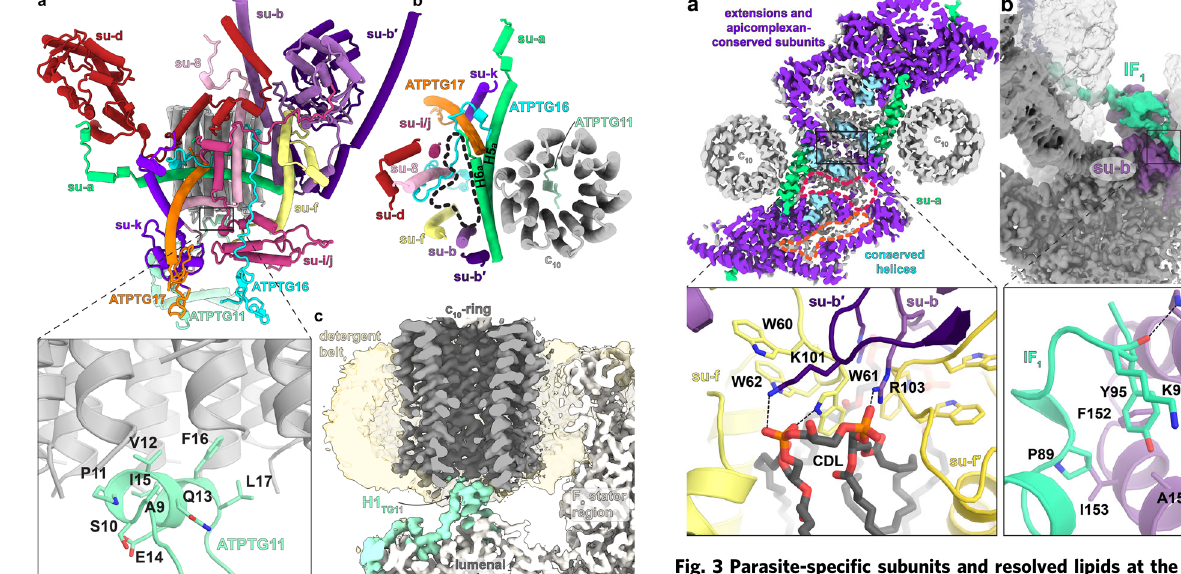
Fig. 3 Parasite-speci fi c subunits and resolved lipids at the dimer interface. a F o map cross-section showing apicomplexa-speci fi c (purple) and conserved (light blue) subunits, as well as lipid vestibules (red, orange). The apicomplexa-speci fi c subunits scaffold the F o architecture. Close-up inset shows protein-cardiolipin (CDL) contact at dimer interface with subunits b and f interacting via a tightly bound cardiolipin. b IF 1 dimer (green density) binds to F o (dark grey density) and F 1 of both monomers (transparent grey), linking them together. Close-up inset shows IF 1 interactions with subunit- b